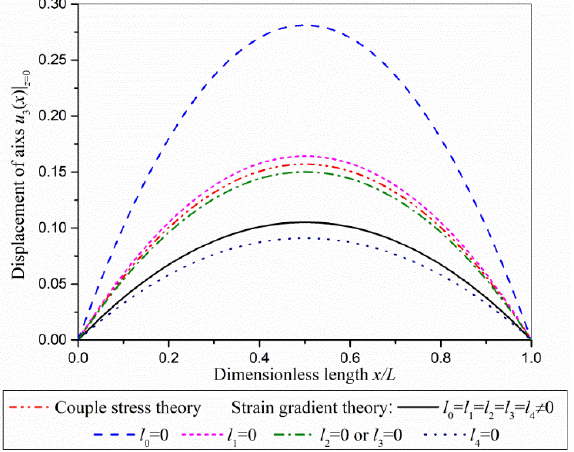
Figure 2. The displacement u 3 of the axis along the length direction of the beam.